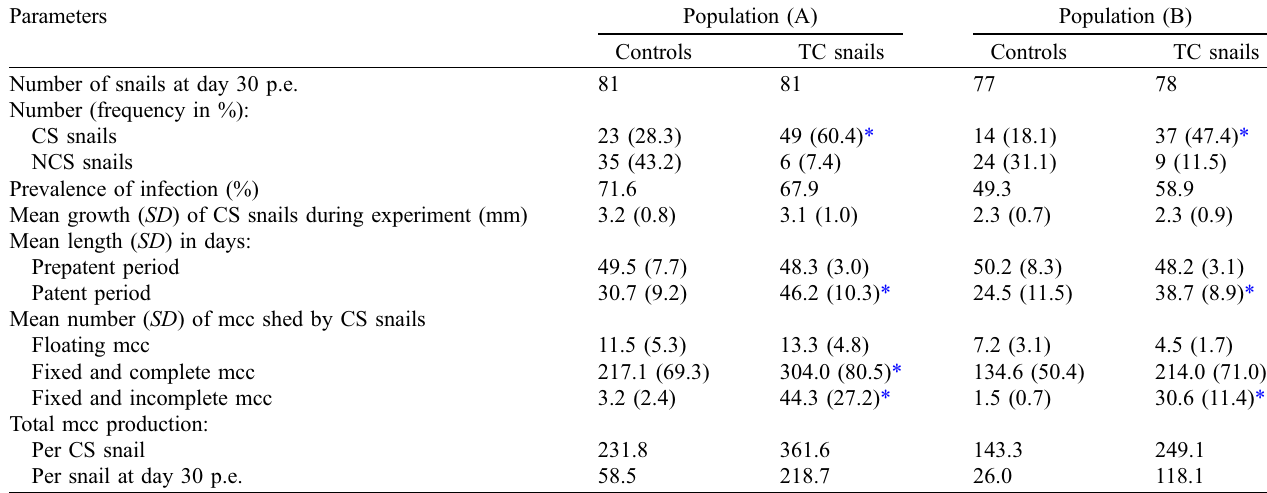
Table 2. Main characteristics of F. hepatica infection in snails maintained to a constant temperature of 20 (cid:2) C (controls), or subjected